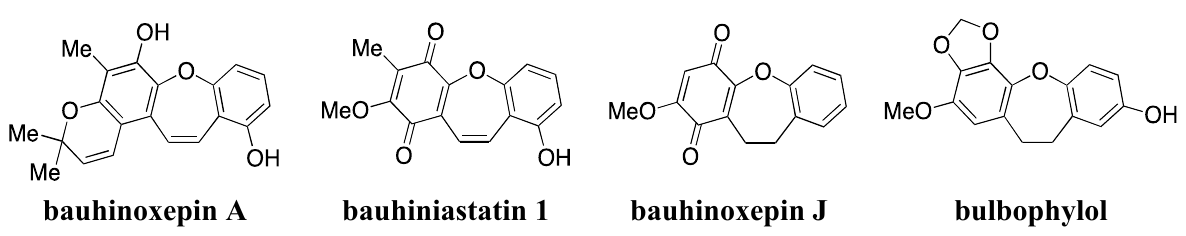
Figure 1. Structure of some natural dibenz[ b , f ]oxepins.